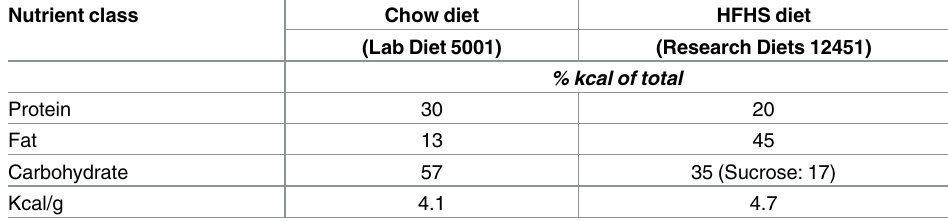
Fig 1. Experimental design and groups for LPA receptor expressionanalysis. Experimental layout of LPA receptor mRNA quantification in A) heart and adiposetissue from non-obese,pre-obese,and obese cardiacsurgery patients, B) heart, adiposetissue, and cardiomyocytes from lean and obesemice, C) insulinsensitive and insulinresistant 3T3-L1 adipocytes,and D) insulinsensitive and insulin resistant HL-1 cardiomyocytes.